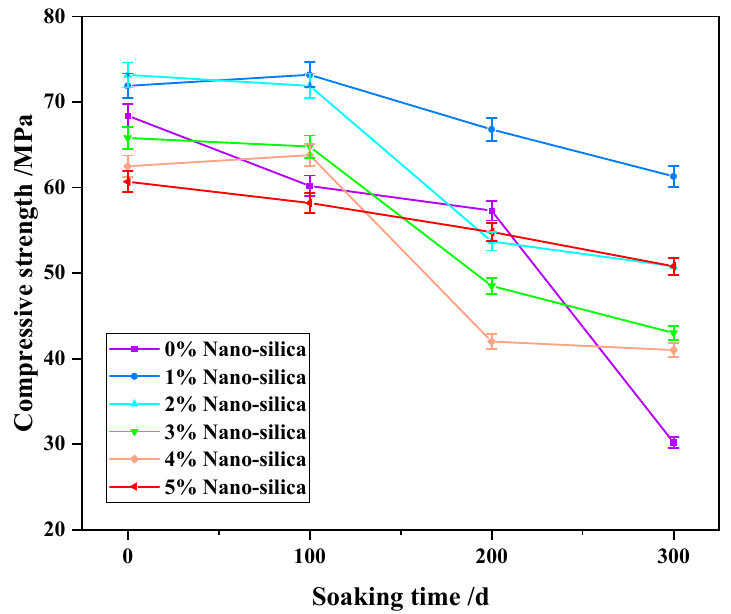
Figure 7. The time-dependent compressive strength of HPC specimens subject to sulfate attack. The variations in splitting strength are similar to that of compressive strength, except for a slight increase after soaking for 100 days. As shown in Figure 8, the peak splitting strength of HPC specimens slightly increases after the first 100 days of soaking, and then decreases with increasing soaking time. After soaking for 300 days, it decreased by 37.2% in unmodified specimens (4.3 vs. 5.9 MPa). Consistent with compressive strength, the 1% NS additive is the most effective dosage in front of sulfate attack, which increased by 10.2%, 16.7%, 34.5%, and 69.8% after soaking for 0 day, 100 days, 200 days, and 300 days, respectively. The splitting strengths were mostly higher in 2%–5% NS HPC specimens compared with unmodified specimens, but they were all less than that of 1% NS specimens.